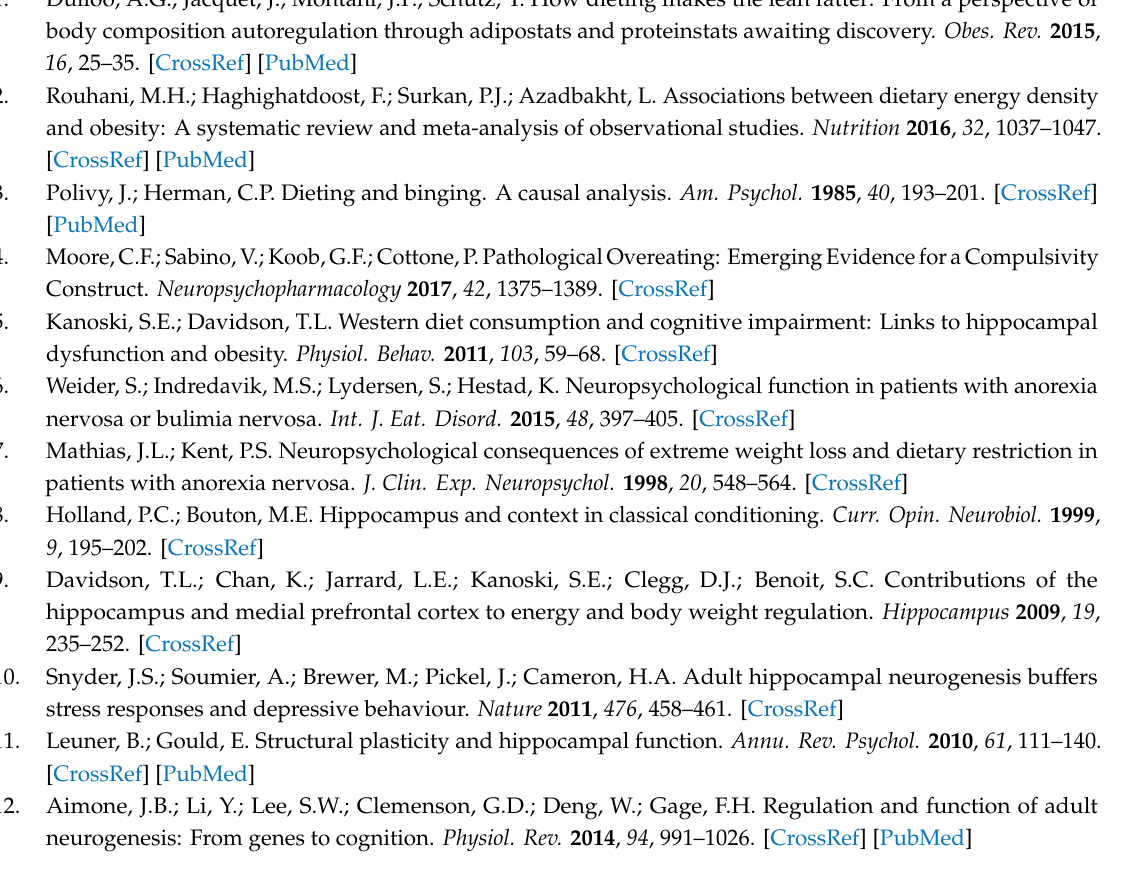
Figure S1: E ff ects of repeated, alternating 5-day access to chow and 2-day access to either chow 13 (Chow / Chow) or highly preferred chocolate-flavored sugary diet (Chow / Palatable) on ( A ) average body weight change, ( B ) cumulative body weight gain, ( C ) Average feed e ffi ciency, and ( D ) cumulative feed e ffi ciency, ( n = 19–20 / group). Data show M ± SEM. * p ≤ 0.05, ** p ≤ 0.01, *** p ≤ 0.001 vs. Chow /